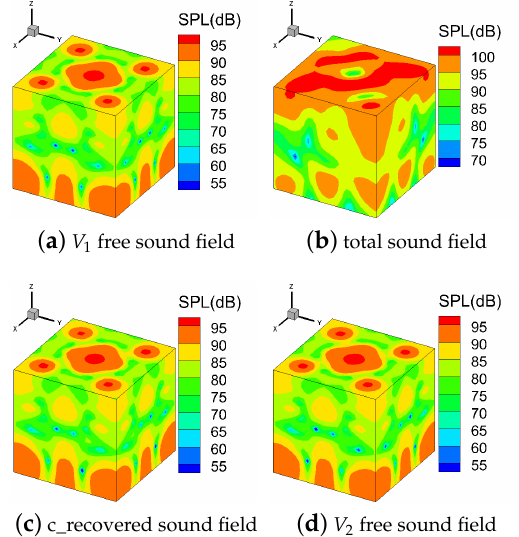
Figure 5. Contour map of sound pressure level (SPL) on the measurement surface at 450 Hz (ka =